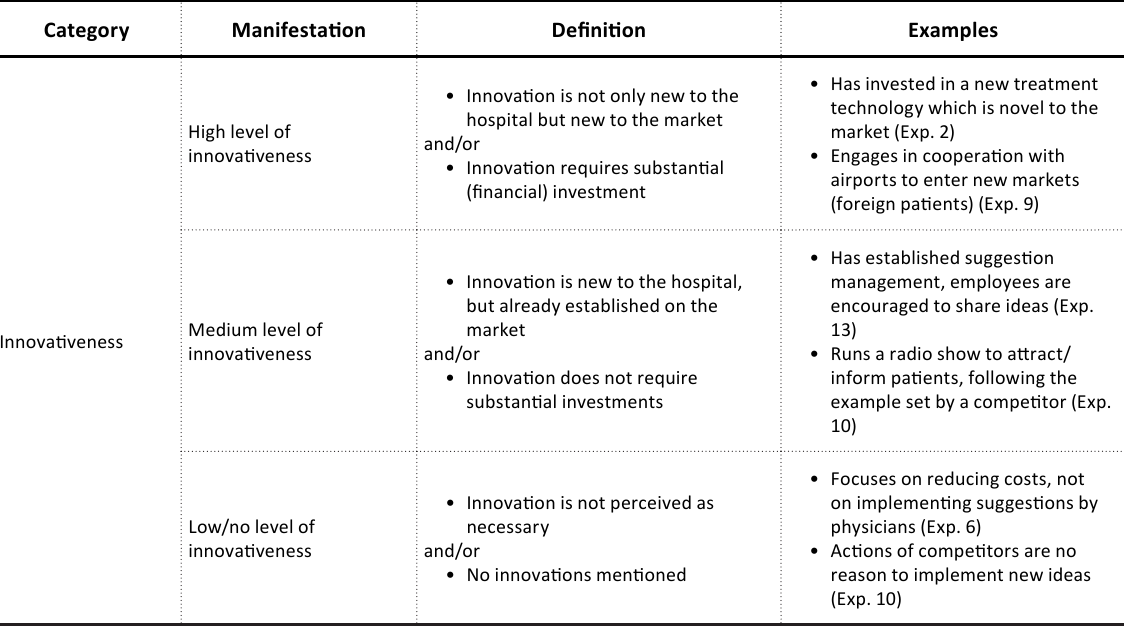
Table A3. Coding guidelines for managerial entrepreneurial